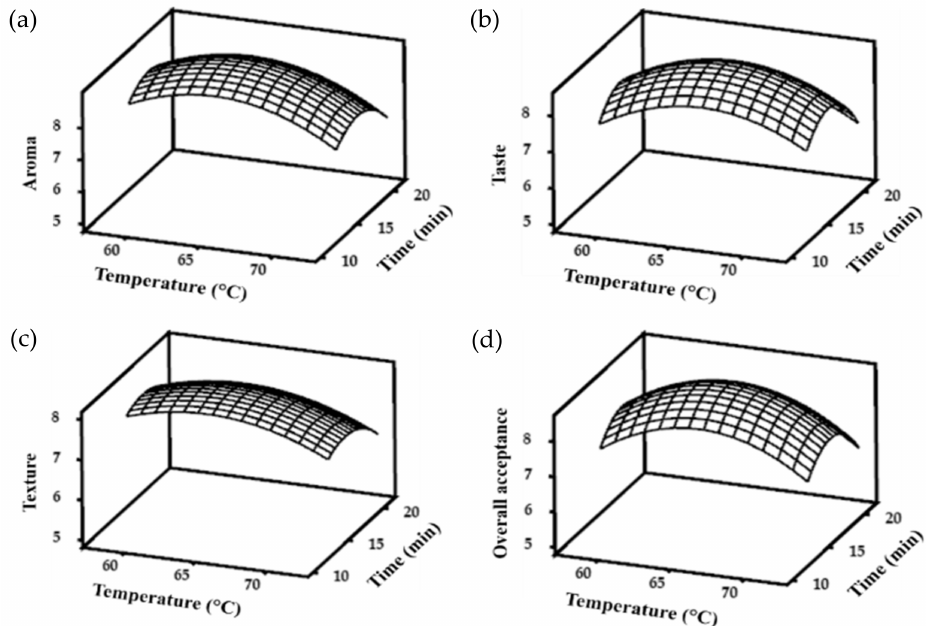
Figure 4. The response wireframe graph for ( a ) aroma, ( b ) taste, ( c ) texture, and ( d ) overall acceptance of smoke-roasted Alaska pollack roe at the designated temperature and